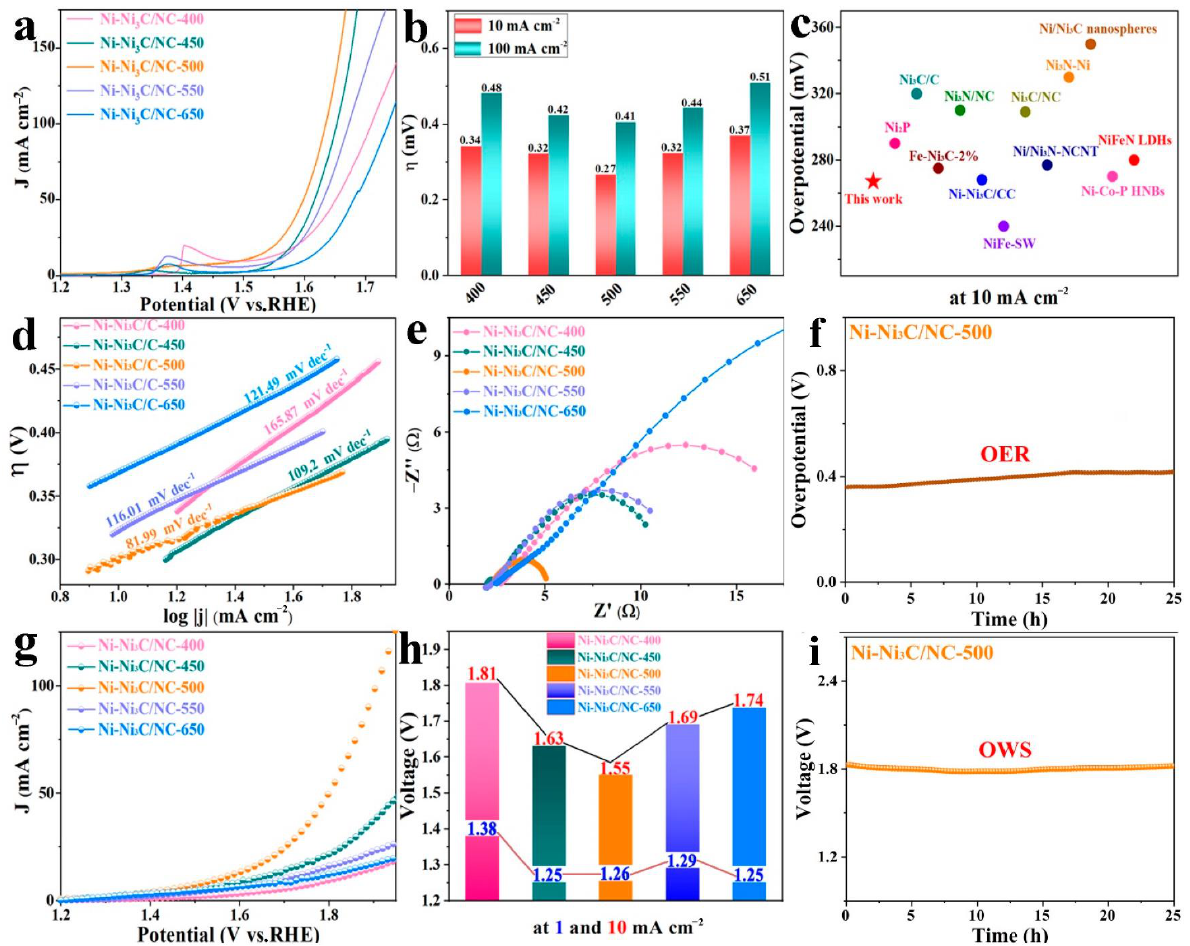
Figure 4. Electrochemical Properties of Ni-Ni 3 C/NC for OER and OWS. ( a ) Polarization curves, ( b ) overpotential plots at 10 mA cm − 2 and 100 mA cm − 2 , ( c ) The comparison of OER overpotentials at 10 mA cm − 2 for different catalysts. ( d ) Tafel slopes, ( e ) The EIS plots of Ni-Ni 3 C/NC measured at an overpotential of 300 mV. ( f ) The long-term stability measurement of Ni-Ni 3 C/NC-500 at a current density of 25 mA cm − 2 for 25 h. ( g , h ) The overall water splitting bi-functional activities were measured on Ni-Ni 3 C/NC in a two-electrode configuration. The comparison of the cell voltage at 1 and 10 mA cm − 2 for Ni-Ni 3 C/NC. ( i ) Time-dependent current density curve of Ni-Ni 3 C/NC in 1 m KOH for 25 h without iR